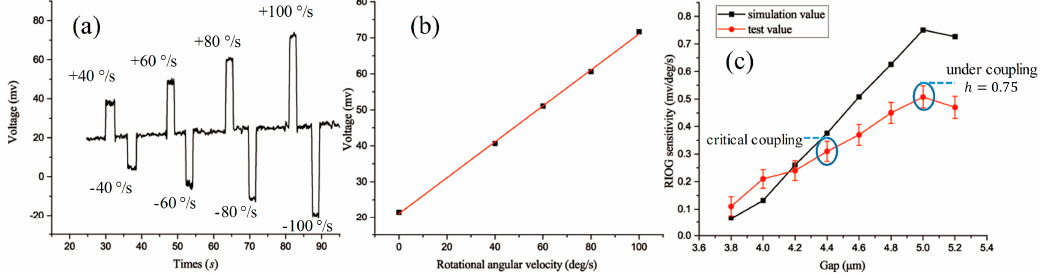
Figure 6. ( a ) Gyroscope signal with different rotational angular velocities; ( b ) fitting analysis of stair effects; ( c ) comparison of measured and simulated values of RMOG sensitivity for the different gaps.